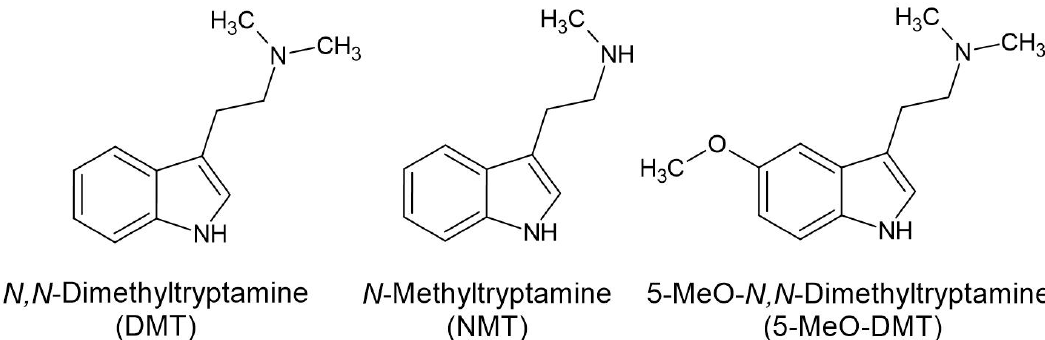
Figure 2. The three psychoactive tryptamines in Acacia , Senegalia and Vachellia